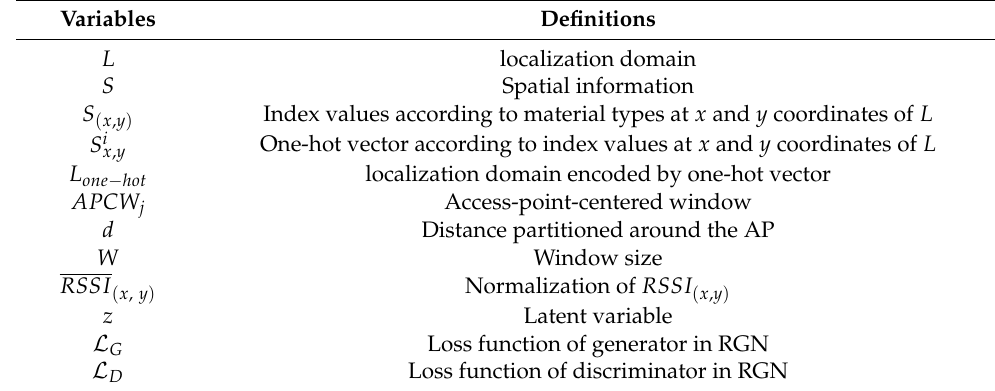
Table 1. Variables used in the APCW-RGN.